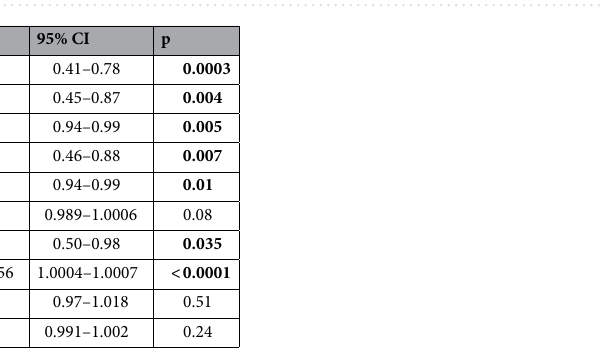
Figure 2. Event-free survival DM patients according DM treatment; MET-treated DM patients had significantly better survival, no significant difference in survival was observed among patients treated with other glucose-lowering agents.